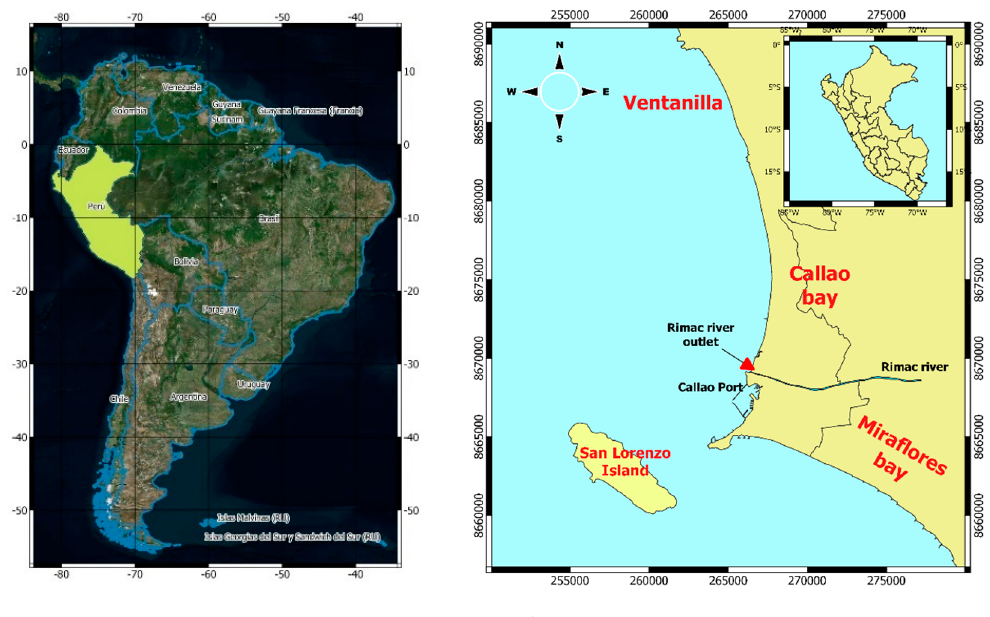
Figure 1. Study area.